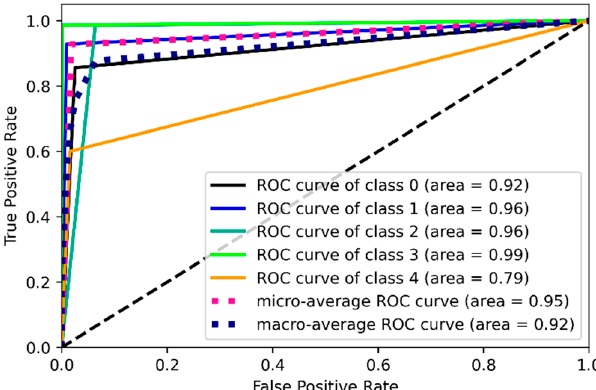
Figure 23. ROC curves and AUC values for three-class experiment by VGG16.